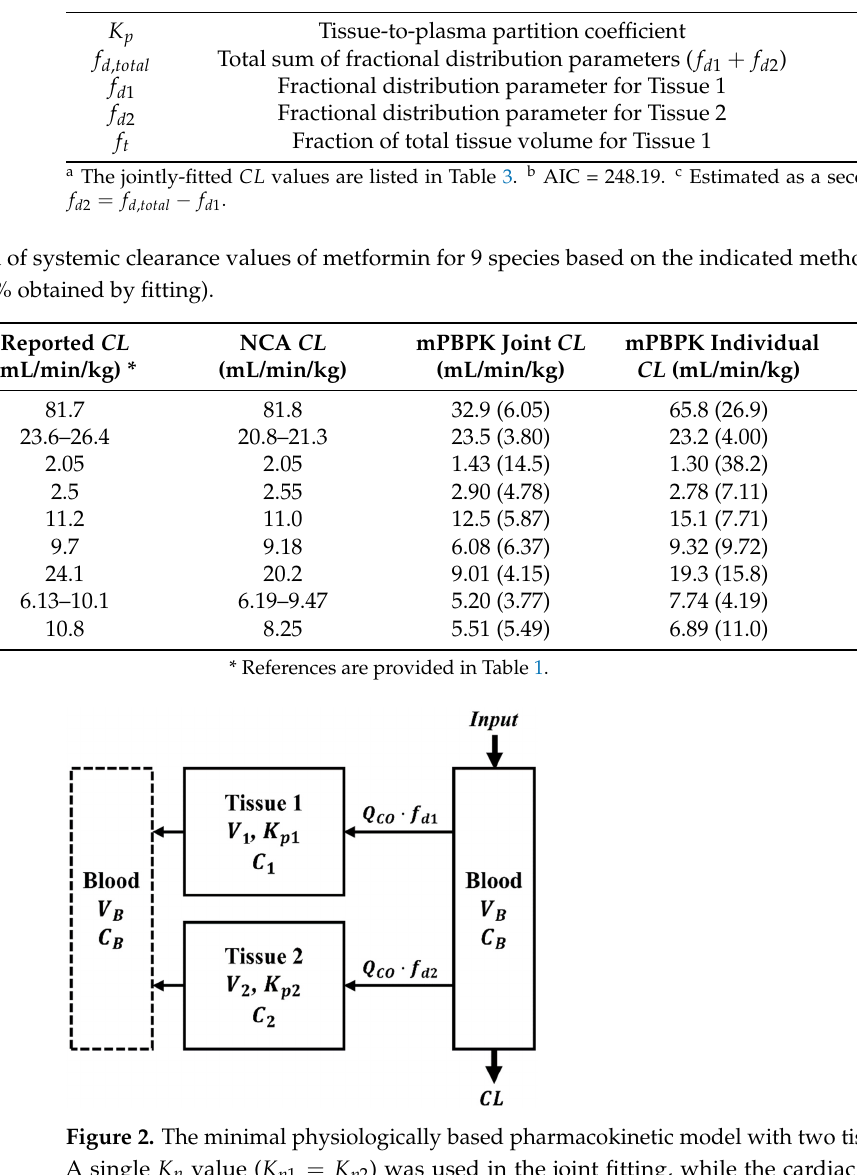
Table 2. Pharmacokinetic parameters of metformin jointly fitted to the minimal physiologically based pharmacokinetic model across 9 species a,b .